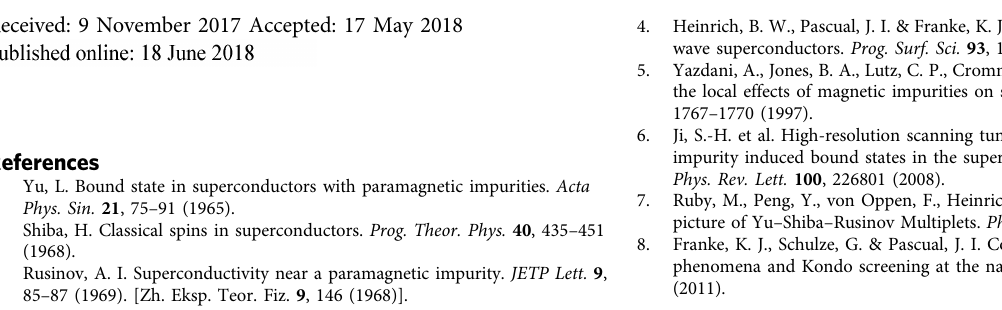
Fig. 4 Tuning interdot coupling t d . a – d Stability diagrams for different voltages on the tuning gate g d while compensating on plunger gates ( T = 30 mK). The plot in d is analyzed in Fig. 3 and the voltage on g d is decreased in steps of − 20 mV from d to a (compensating in steps of 10 and − 15 mV on g N and g S , respectively). e – h , Stability diagrams generated by the zero-bandwidth model for different t d (in meV), qualitatively reproducing the experimental behavior in a – d . Orange regions marking ground state transition have singlet-doublet splitting less than 0.015 meV. i , j , m , n Bias spectroscopy of sub-gap states vs. individual plunger gates swept along red, and green arrows in c and a . All plots show clear sub-gap resonances consistent with the ground states (doublet D or singlet S ) for different gate voltages indicated below. k , l , o , p Zero-bandwidth model calculation of sub-gap excitations for t 0.125 meV corresponding to experimental plots i , j , m , n . The triplet excitation has very low spectral weight and therefore does not show up in the measured bias spectroscopy. Parameters are fi xed to the same values as in Fig.